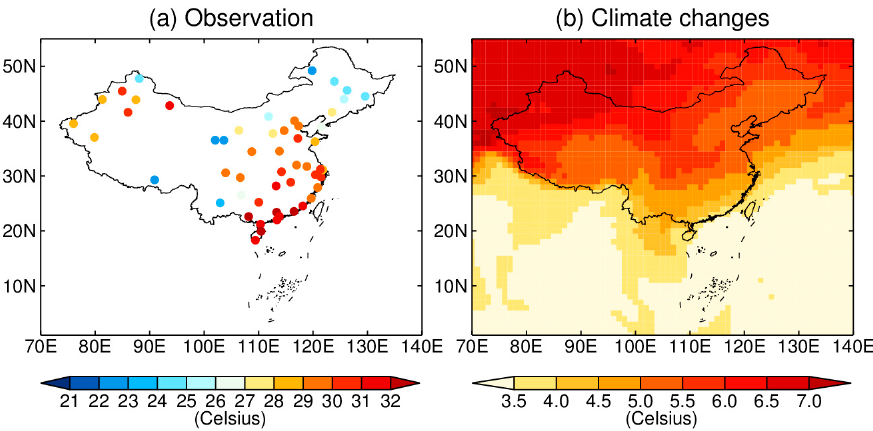
Figure 2. ( a ) The summer-mean daily maximum temperature in observations. ( b ) Change of the summer-mean daily maximum temperature in the CMIP6 simulations (multi-model mean) in 2091–2100 relative to 2005–2014. The plotted data is tabularized in Table S3.